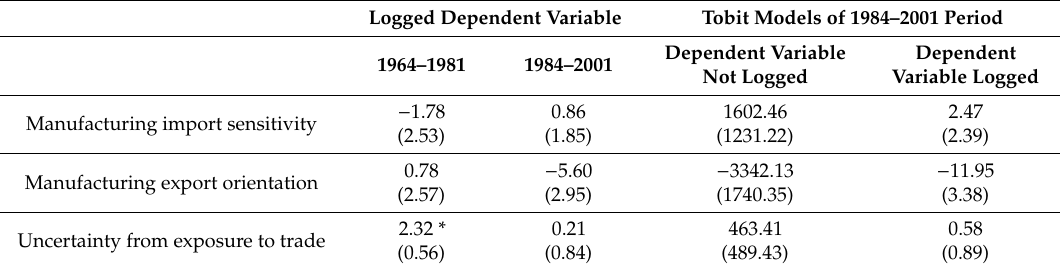
Table A2. Alternative Models of Person-Days Lost to Work Stoppages in U.S.